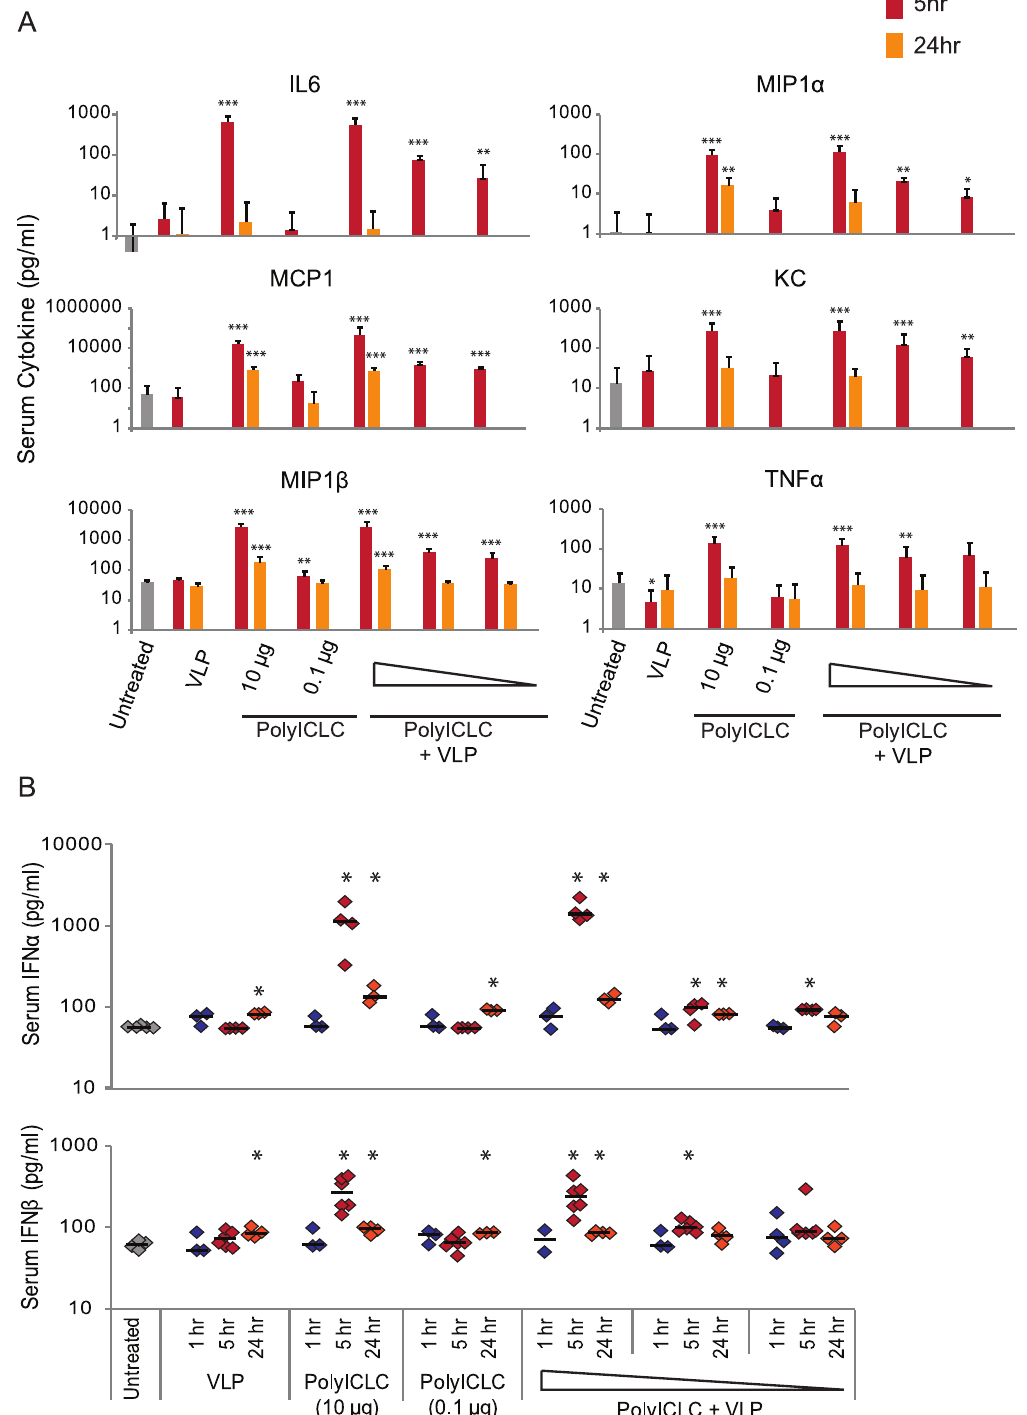
Figure 5. PolyICLC induces transient increases in serum cytokine and chemokine levels . C57BL/6 mice were vaccinated with 1.25 m g of VLP, 10 m g of polyICLC, 0.1 m g of polyICLC, or 1.25 m g of VLP with 10, 1, or 0.1 m g of polyICLC. One hour, five hours, or twenty-four hours after vaccination, peripheral blood was collected and evaluated for cytokine and chemokine levels. Supernatant from splenocytes stimulated with PMA/ ionomycin or LPS served as a positive control to evaluate consistency between assays and to confirm the efficacy of cytokine and chemokine detection. (A) Six cytokine and chemokines that consistently increased in mouse serum after polyICLC or VLP (1.25 m g) treatment. Red bars indicate levels five hours after vaccination; orange bars indicate levels twenty-four hours after vaccination. The gray bar indicates the levels detected in untreated mice. Mean and standard deviation are shown. Triangle indicates decreasing dose levels of polyICLC (10 m g, 1 m g, 0.1 m g) administered in combination with 1.25 m g of VLP. (B) IFN a and IFN b levels in the serum were detected using an ELISA. Median is indicated with the black bar. Triangle indicates decreasing dose levels of polyICLC (10 m g, 1 m g, 0.1 m g) administered in combination with 1.25 m g of VLP. The unpaired, two-tailed Mann-